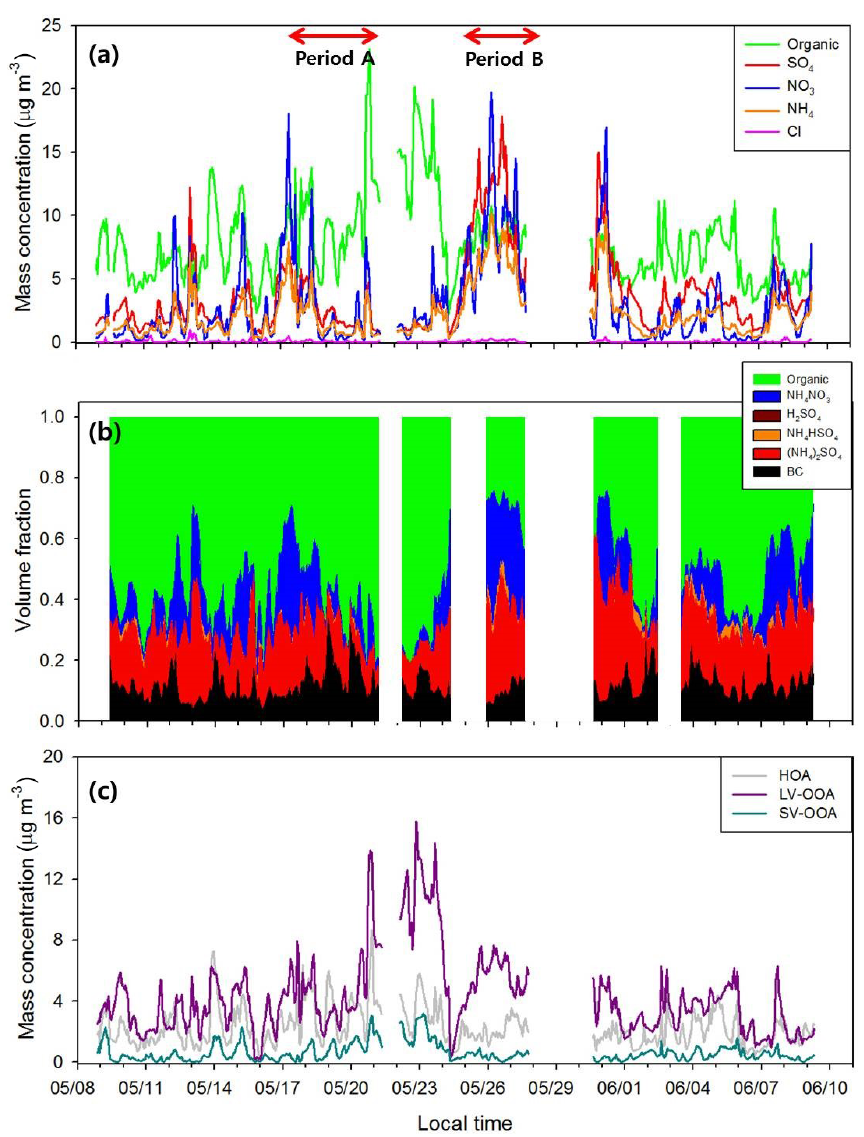
Figure 1. Time series of (a) mass concentration and (b) volume fraction of aerosol chemical composition, and (c) mass concentration of three organic aerosol (OA) factors (additional blanks in the time series of the volume fraction of chemical composition in panel b is due to BC